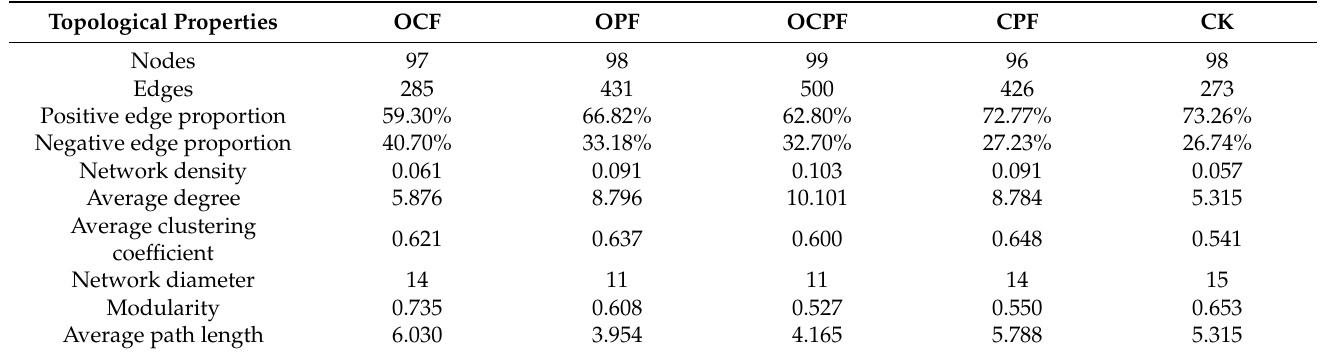
Table 2. Topological properties of bacterial communities’ co-occurrence network for different treat- ments in the teak plantation.